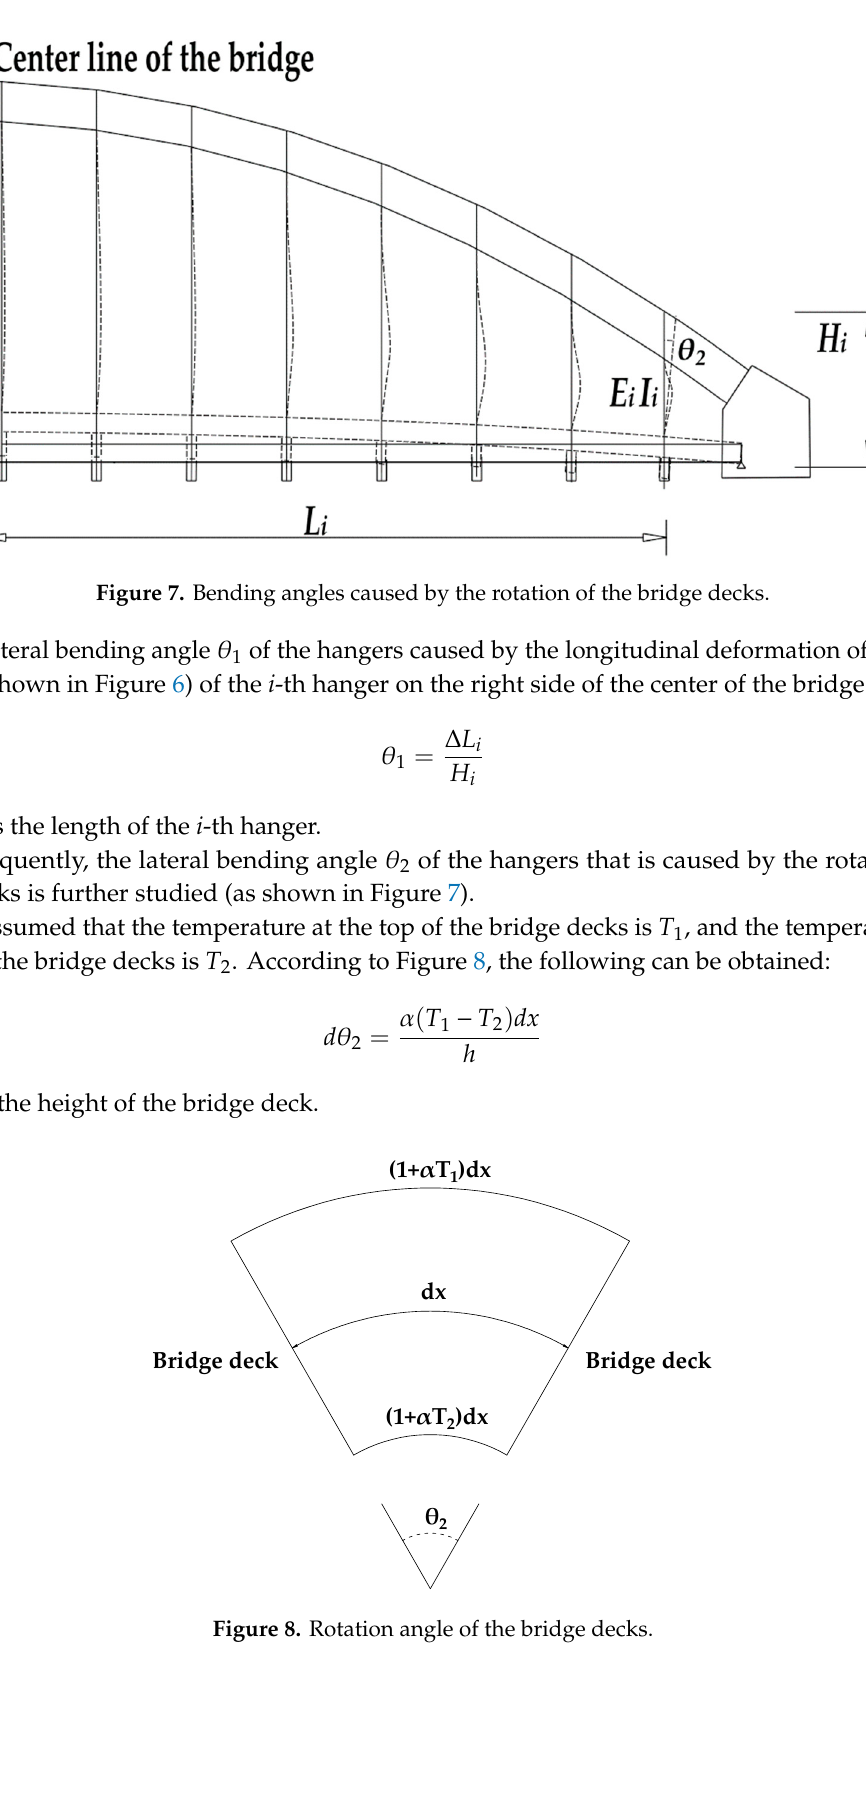
Figure 6. Lateral bending deformation of the hangers under the longitudinal deformation of bridge decks.